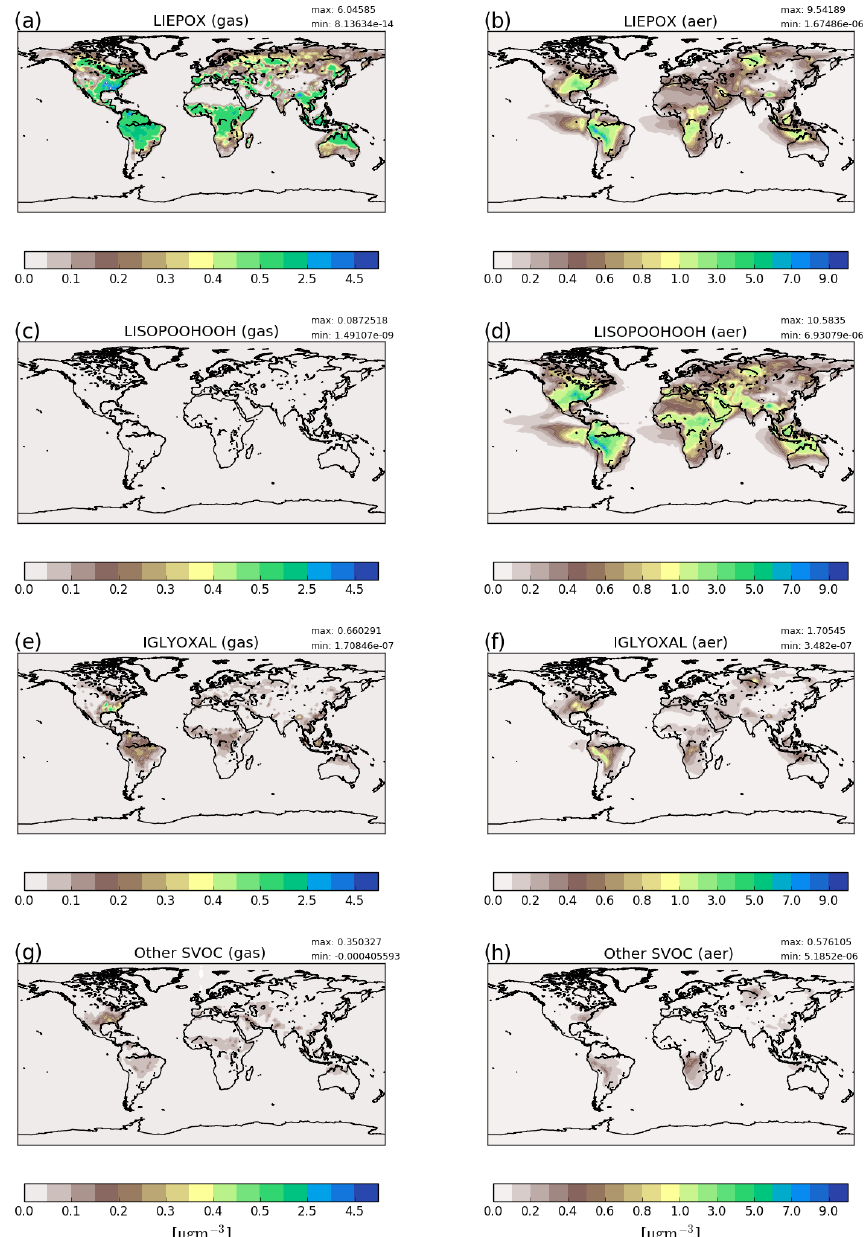
Figure 3. Reference run average surface distribution of precursor gases (a, c, e, g) and corresponding component concentration in the particle phase (b, d, f, h) in µgm − 3 for June, July and August 2012. Since concentrations of non-LISPOOHOOH iSOA are below 1µgm − 3 , they are shown together in (g) and (h) . Different scales are used for precursors and iSOA to capture the concentration ranges accordingly. Note that the concentration scales are not linear and focus on low